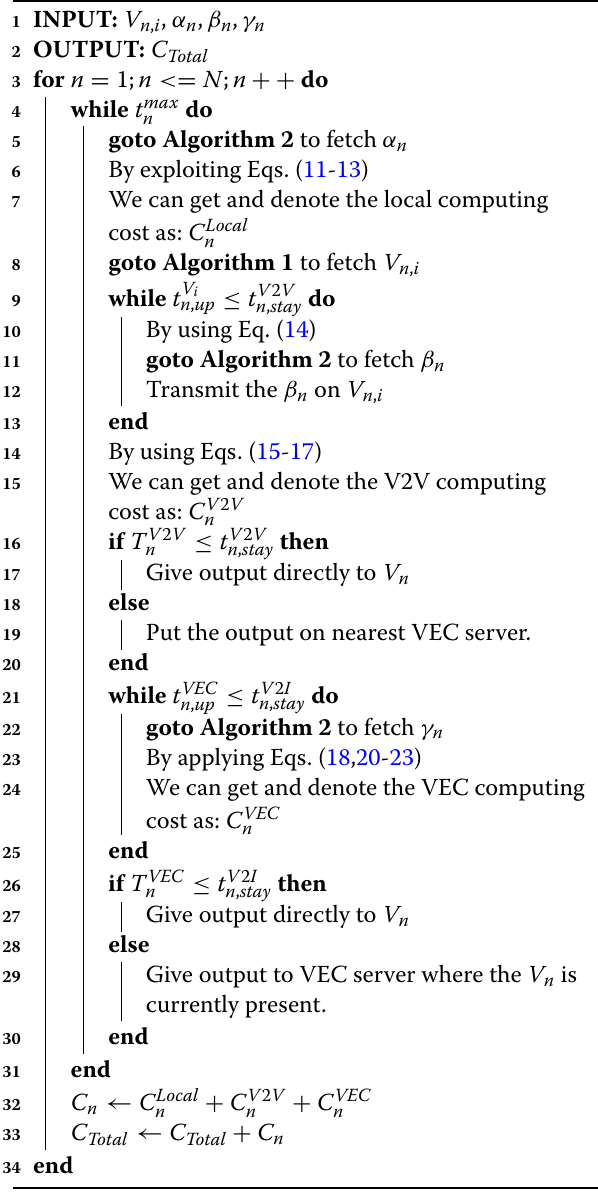
Algorithm 3: MAP Task Offloading